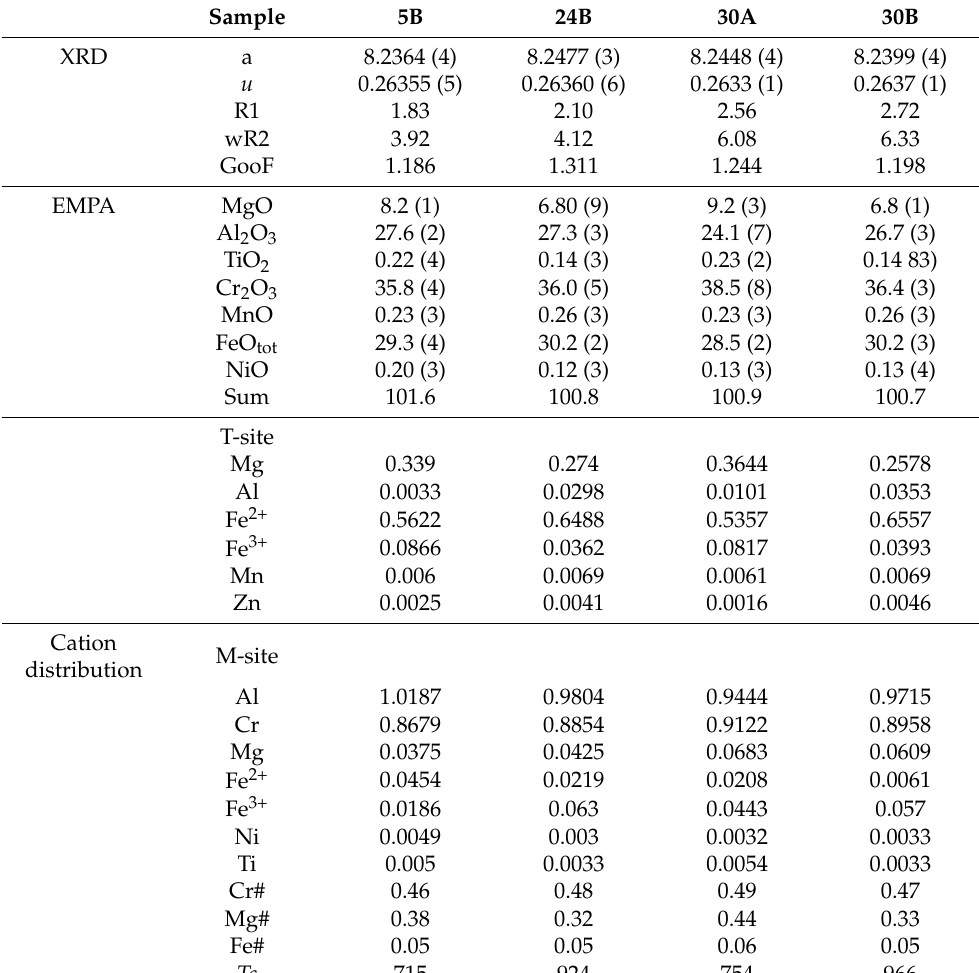
Table 1. Results of structure refinement, chemistry and cation distribution. a: cell parameter (Å); u : oxygen positional parameter; R1: all (%); wR2: (%); GooF: as defined in [40]; Cr#: Cr/(Cr + Al); Mg#: Mg/(Mg + Fe 2+ ); Fe 3+ #: Fe 3+ /(Fe 3+ + Cr + Al); Tc : intracrystalline closure temperature ( ◦ C), calculated by using [26] geothermometer. Sample